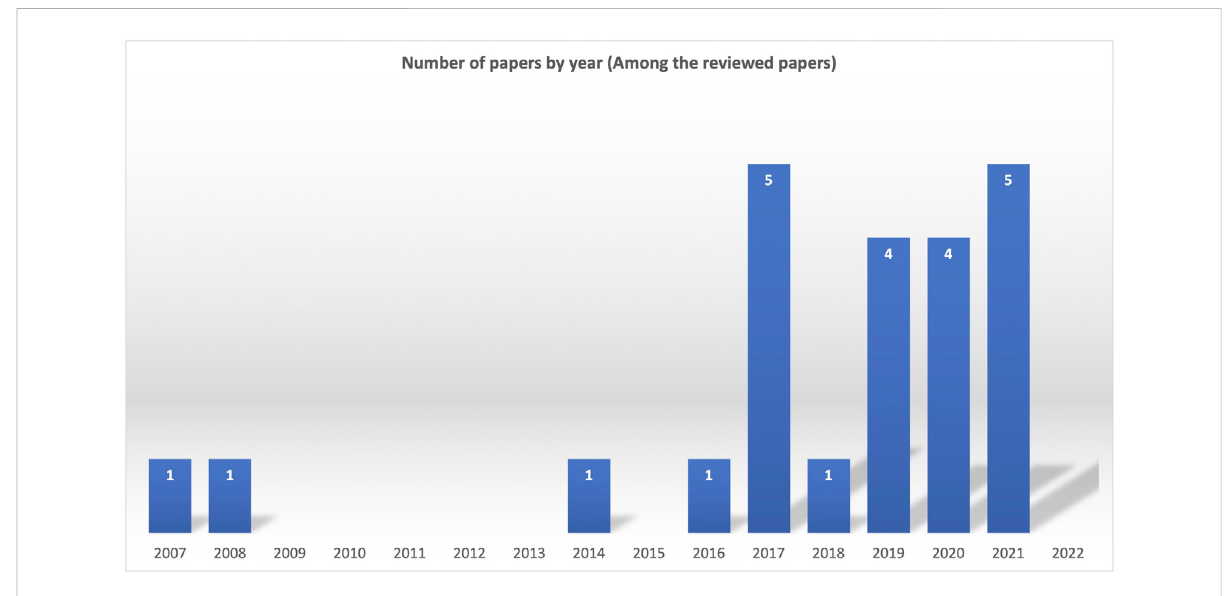
Number of reviewed papers by publication